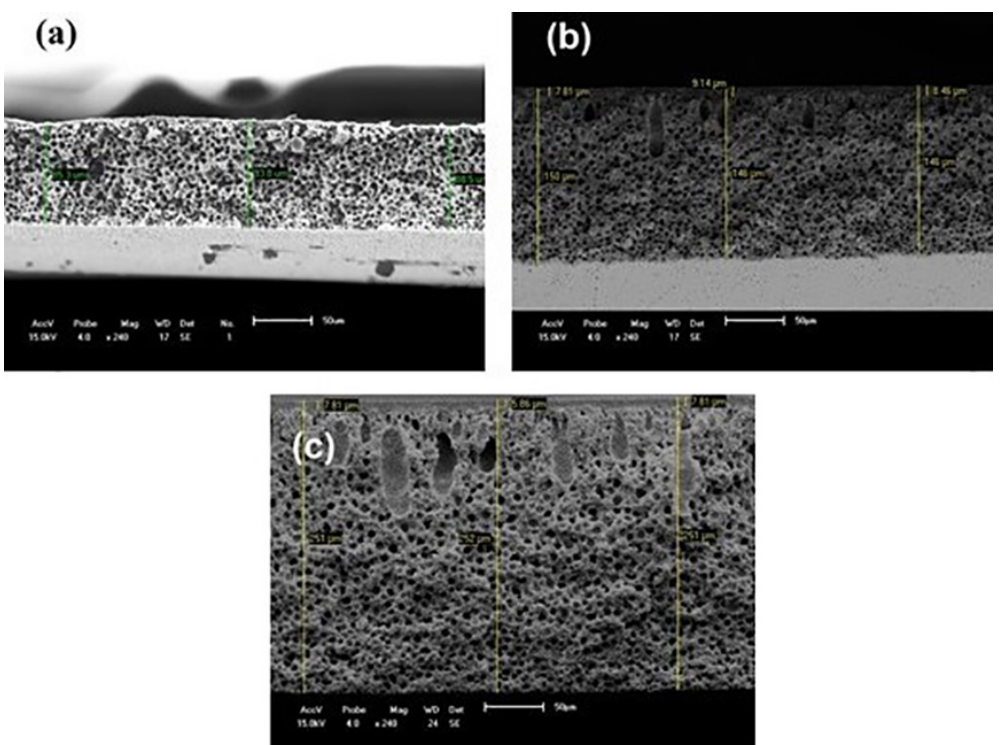
Figure 8. SEM cross-sectional images of the membranes with precipitation bath with 10% of formic acid: (a) PA6; (b) PA6 + 3%MMT and (c) PA6 +